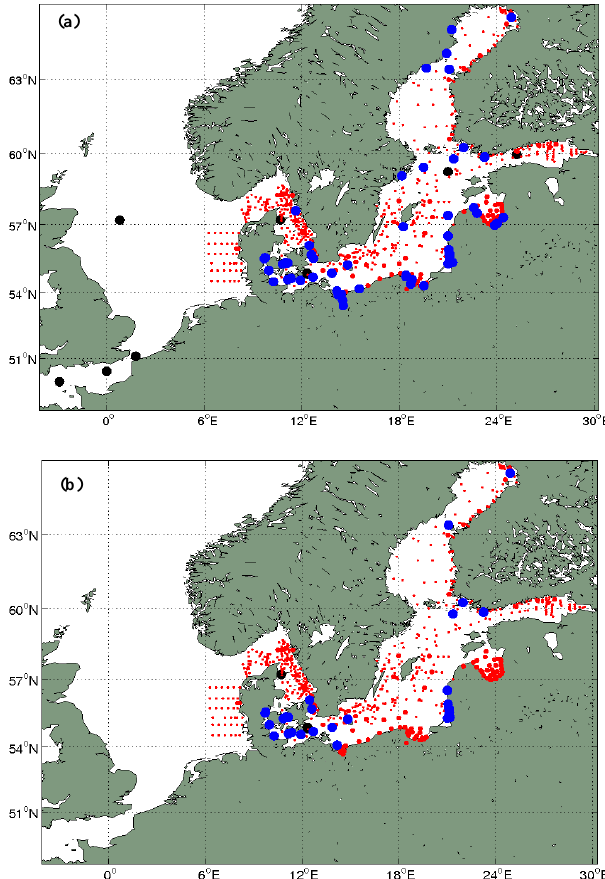
Figure 1, Spatial distribution of the meta data for temperature (a) and salinity (b) measurements during 2004-2006 in the Baltic Sea and North Sea. The CTDs are marked in red dot, the station observations are in blue and the black dot denotes the buoys. The sizes of the dots correspond to the time frequency of the observations.